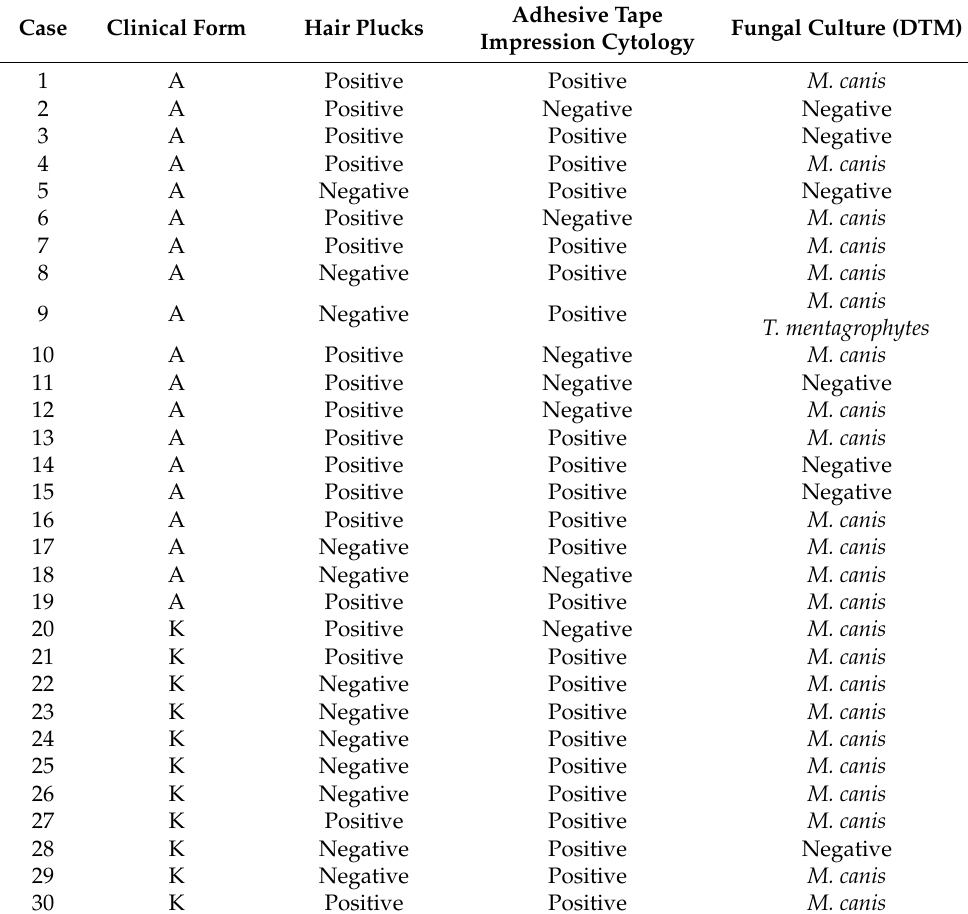
Table 2. Results of diagnostic tests in 30 dogs with dermatophytosis. (A = Alopecia, K = Kerion, ND = Not done).